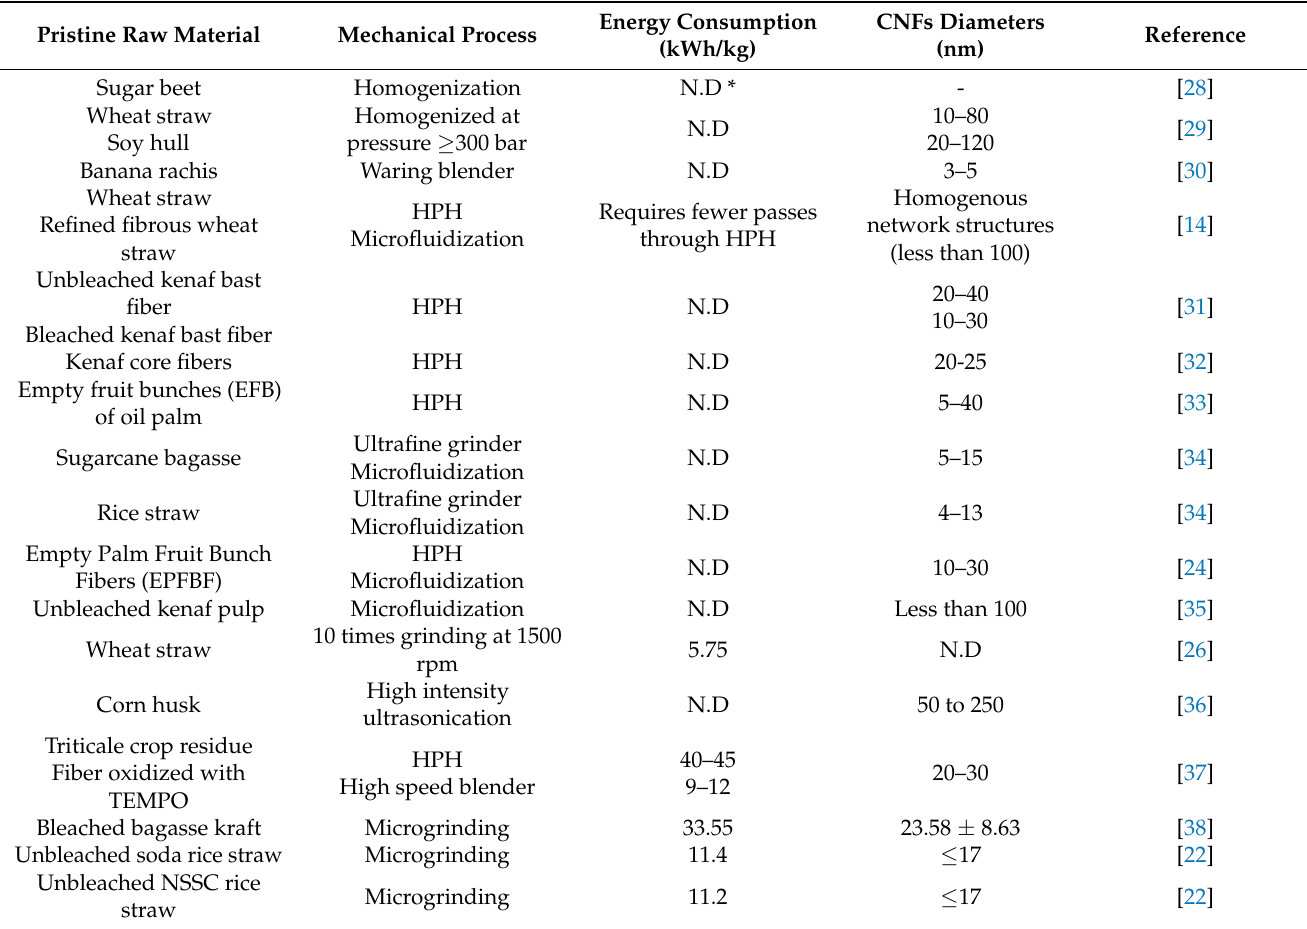
Table 1. Different mechanical routes for the production of CNFs prepared from various non-wood plant fibers and their relevant